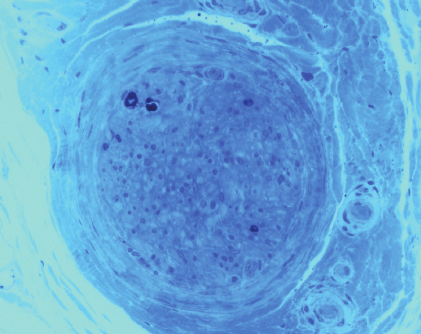
Figure 1: Semithin section of the sural nerve showing a subtotal loss of myelinated nerve fibres. (Semithin toluidine blue section, × 40 oil immersion).